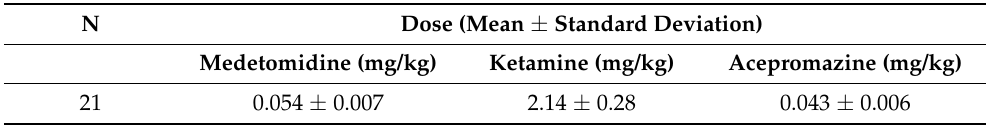
Table 2. Mean anesthetic dosages administered to the captured Apennine chamois. N Dose (Mean ± Standard Deviation) Medetomidine (mg/kg) Ketamine (mg/kg) 21 0.054 ± 0.007